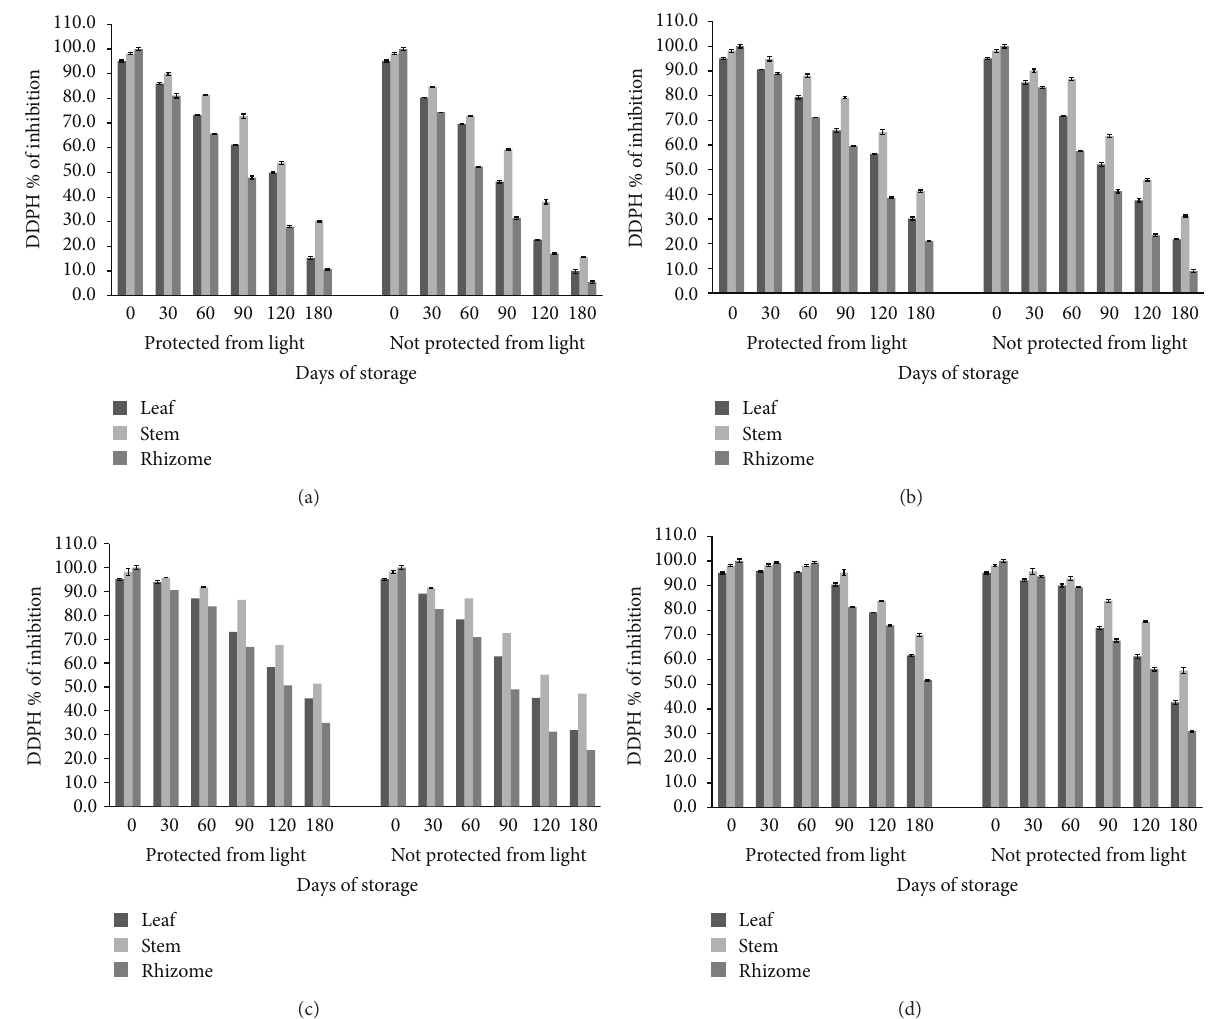
Figure 1: 2,2-Diphenyl-1-picrylhydrazyl (DPPH) % of inhibition from extracts of Anemopsis californica. Storage during 180 days of storage at 50 (a), 25 (b), 4 (c), and − 20 ∘ C (d), protected and not protected from